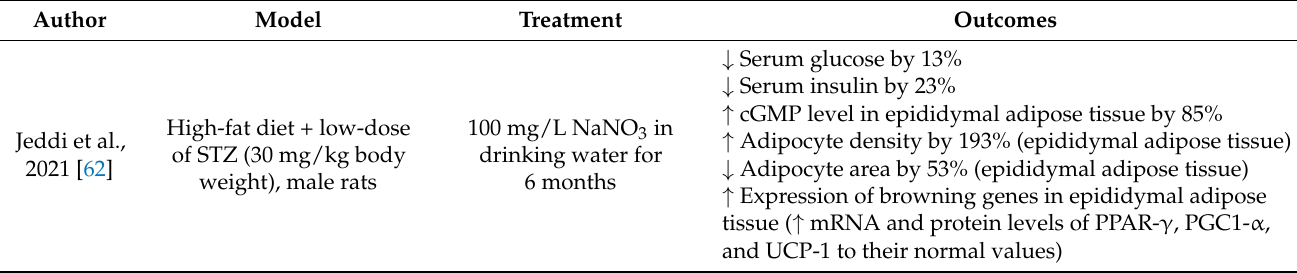
Table 1. The effects of NO 3 − and NO 2 − on glucose and insulin homeostasis, and cardiometabolic disorders in experimental models of type 2 diabetes mellitus and insulin